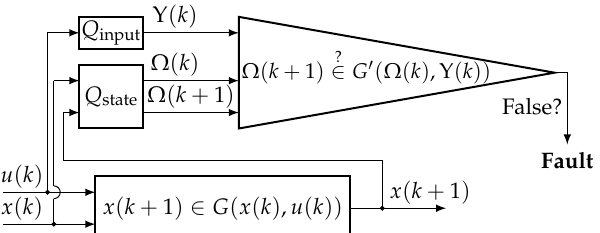
Figure 2. Illustration of the fault detection algorithm applied to a plant ( X , U , G ) with discrete approximation ( X (cid:48) , U (cid:48) , G (cid:48) ) and quantizers